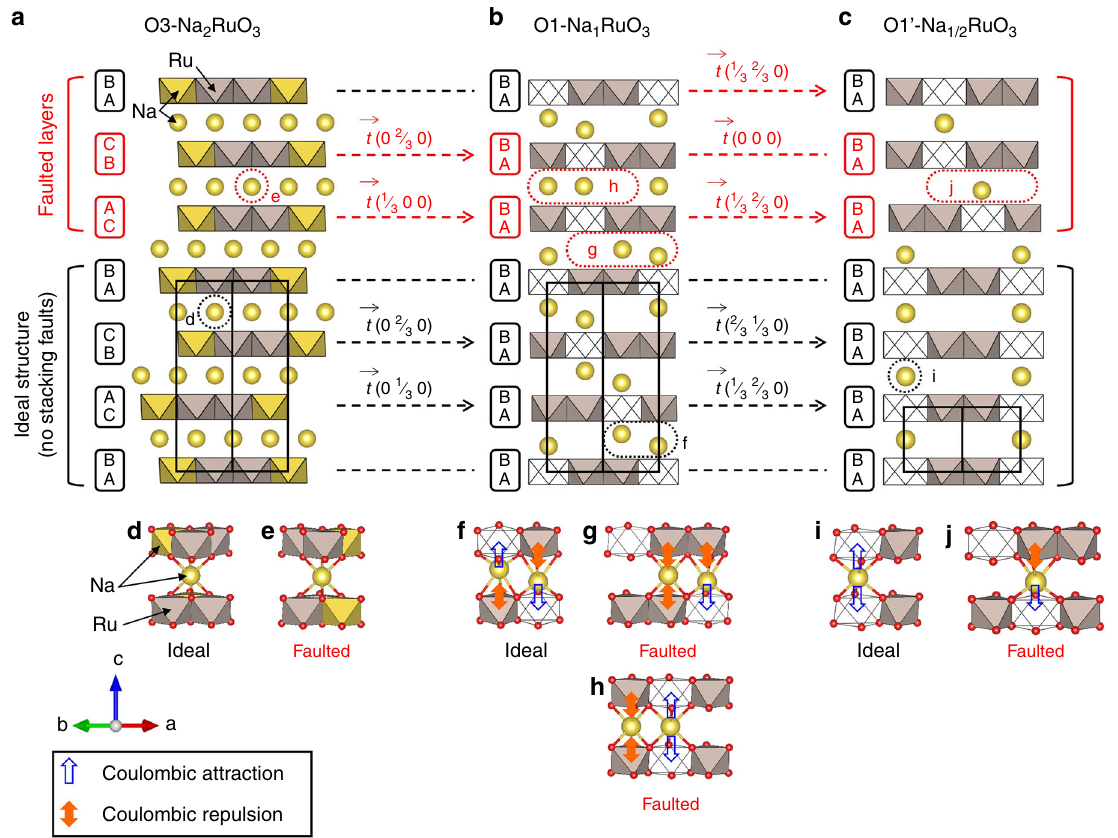
Fig. 4 Coulombic forces and resultant stacking – fault – depression (self-ordering) in Na 2 − x RuO 3 . Structural representation and projected stacking sequences of the Ru atoms of a O3-Na 2 RuO 3 , b O1-Na 1 RuO 3 and c O1 ′ -Na 1/2 RuO 3 . The monoclinic cell of O3-Na 2 RuO 3 has been converted to a pseudo-hexagonal supercell (black lines) for comparison. The transition vectors in the hexagonal supercell from one [Ru 2/3 Na 1/3 ]O 2 or [Ru 2/3 □ 1/3 O 2 ] layer to another are indicated with respect to the pseudo-hexagonal or hexagonal cells. Note that the transition vectors assigned to faulted layers are a few examples out of many possibilities listed in Supplementary Figs. 5 and 6. d ‒ j Comparison of the Na environments in ideal and faulted stacking highlighted with